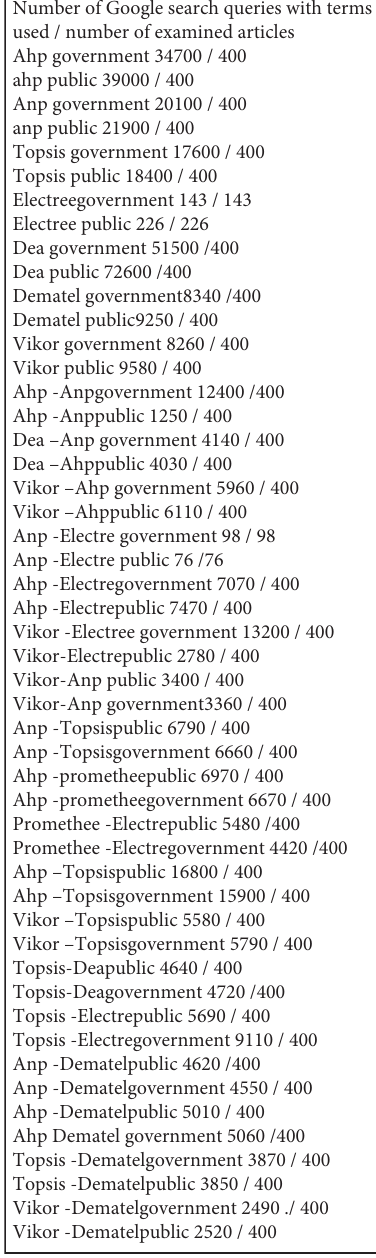
Figure 1: Flow diagram of the included